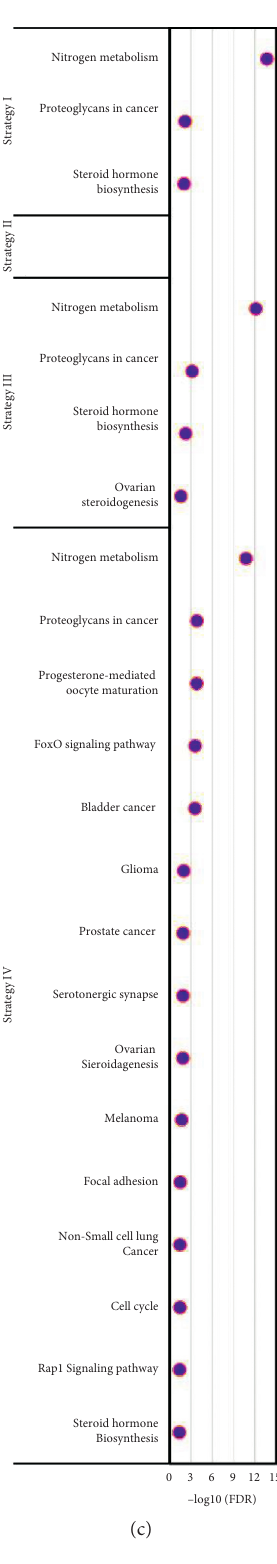
Figure 2: Statistical and enrichment analyses of herbal targets. (a) Number of common or unique targets in diverse herbal strategy. (b, c) -log10(FDR) values of recruited (b) biological processes, molecular functions, cellular components, and (c) pathways in each herbal